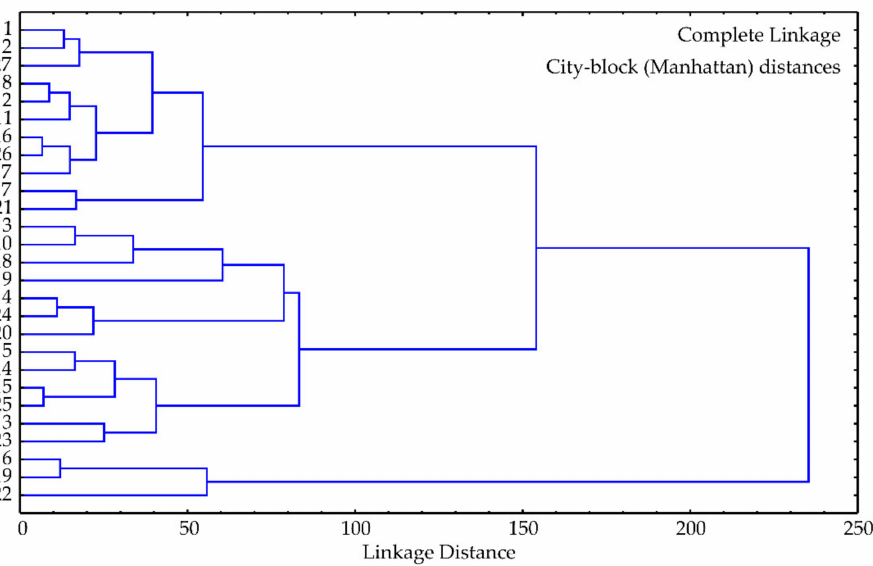
Figure 3. Cluster analysis of the observed samples. OA—dimethachlor oxalic acid, ESA—dimethachlor ethanesulfonic acid and